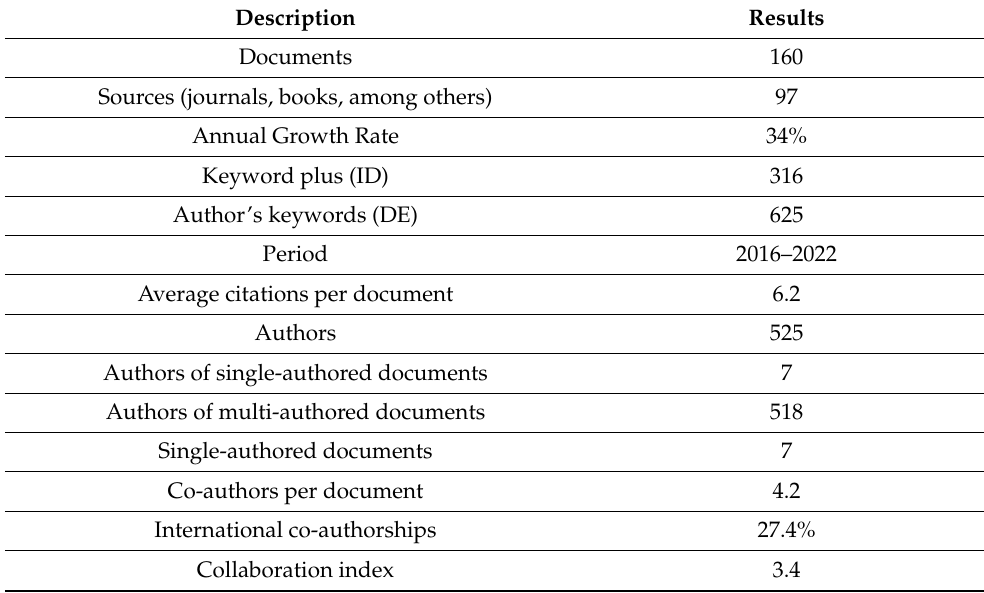
Table 2. Bibliographic data